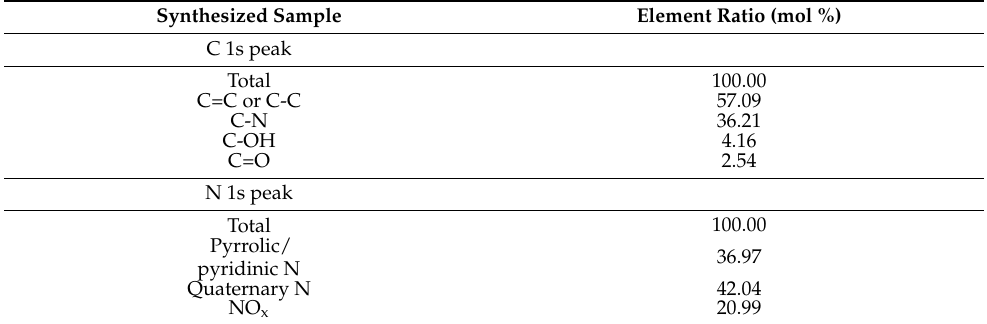
Table 1. XPS analysis showing different percentages of bonding groups in the N-CQD sample.